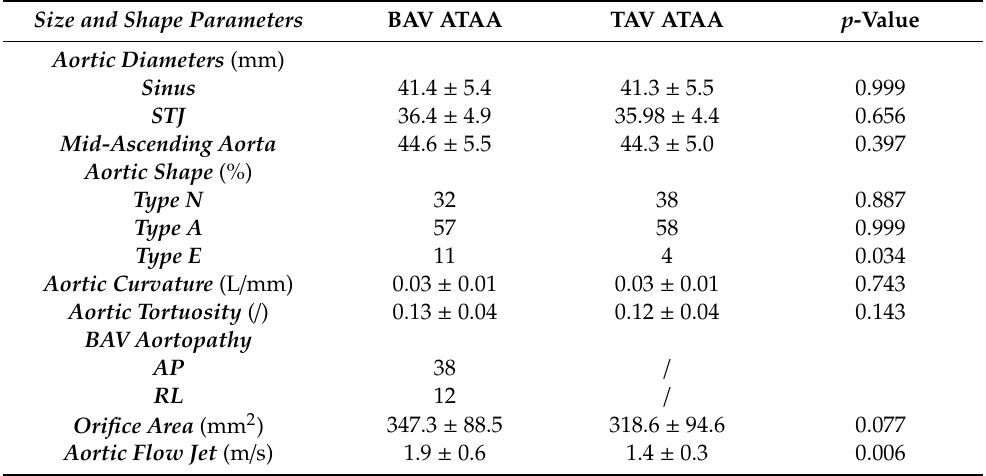
Figure 1. Sketch of an ascending thoracic aortic aneurysm (ATAA) showing measurements of aortic morphology taken for each patient. Table 2. Morphological characteristics of patient population. Mann-Whitney test with α = 0.05.